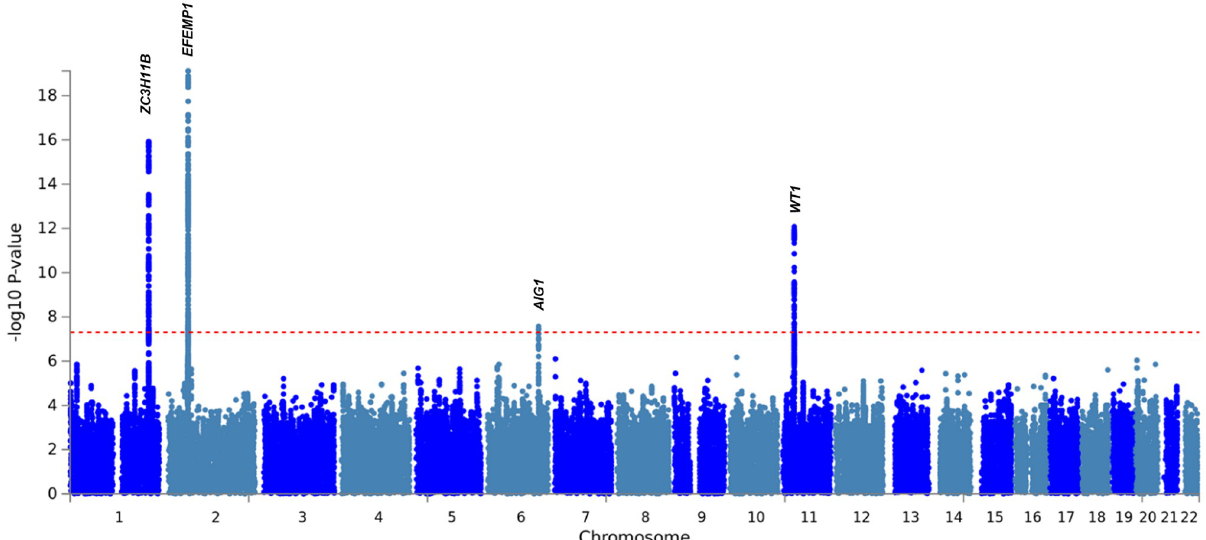
Fig 4. Manhattan plot of the overlap hernia cohort GWAS analyses. Manhattan plot is annotated with the gene names of loci that demonstrated shared susceptibility across two or more individual analyses.